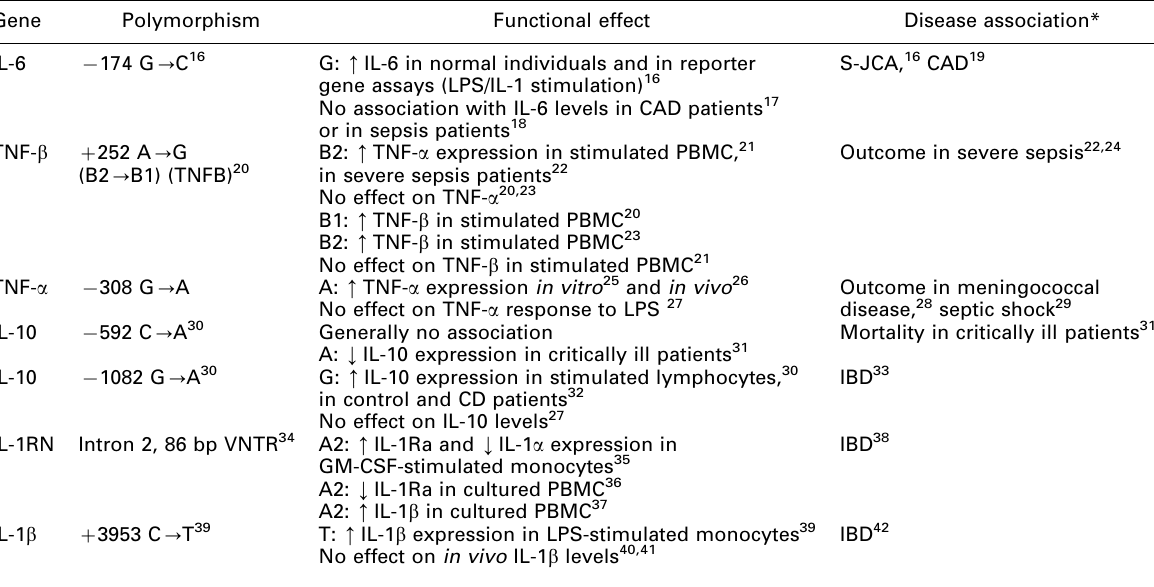
Table 1. Cytokine gene polymorphisms: effects on gene expression and disease associations Gene Polymorphism Functional effect Disease